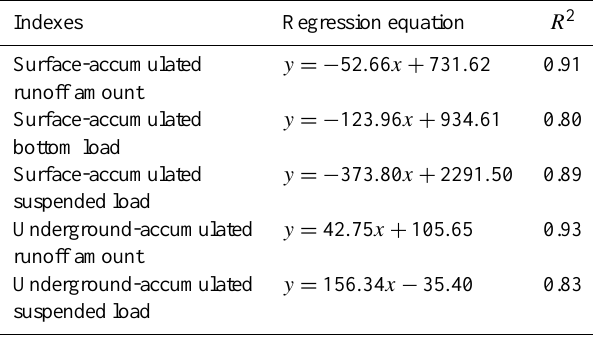
Table 5. Regression equation of accumulated runoff and sediment production and underground pore fissure degree ( x